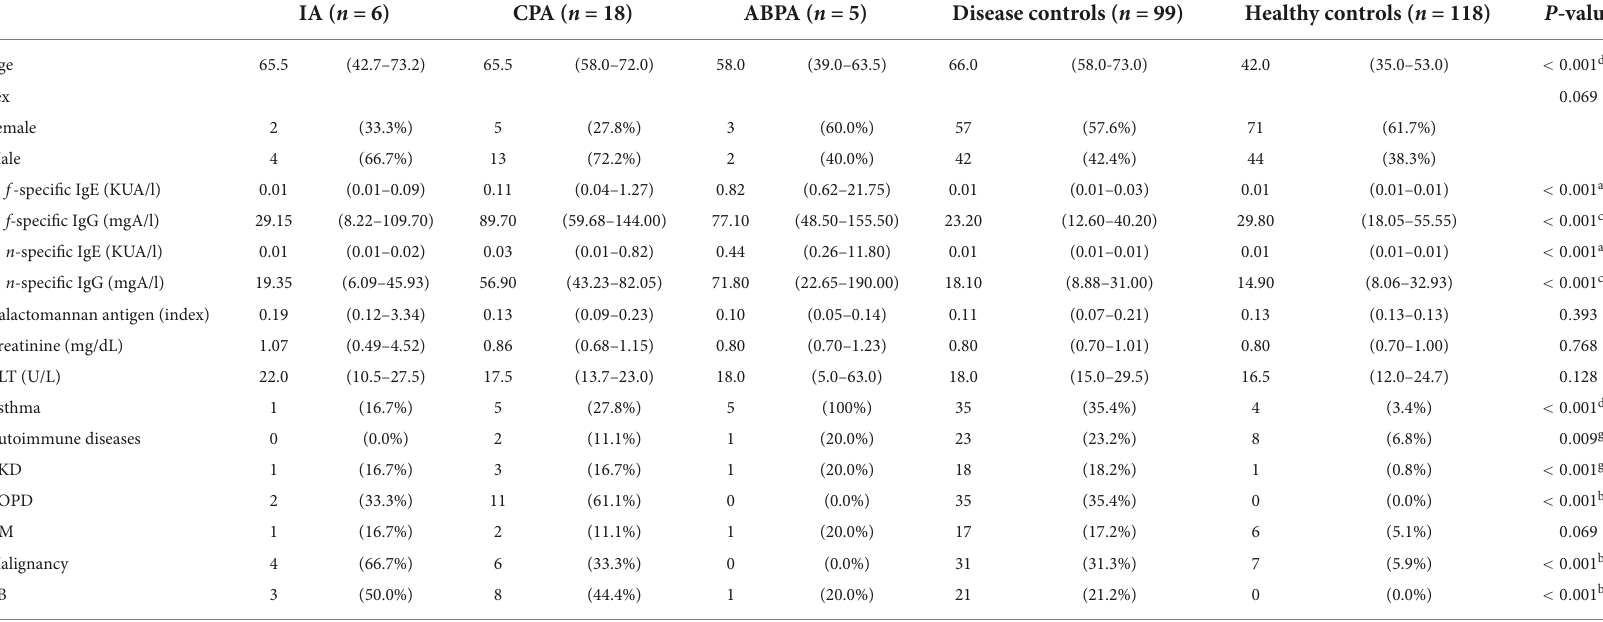
TABLE 1 Comparing the demographic data of patients with aspergillosis, the disease controls, and the healthy